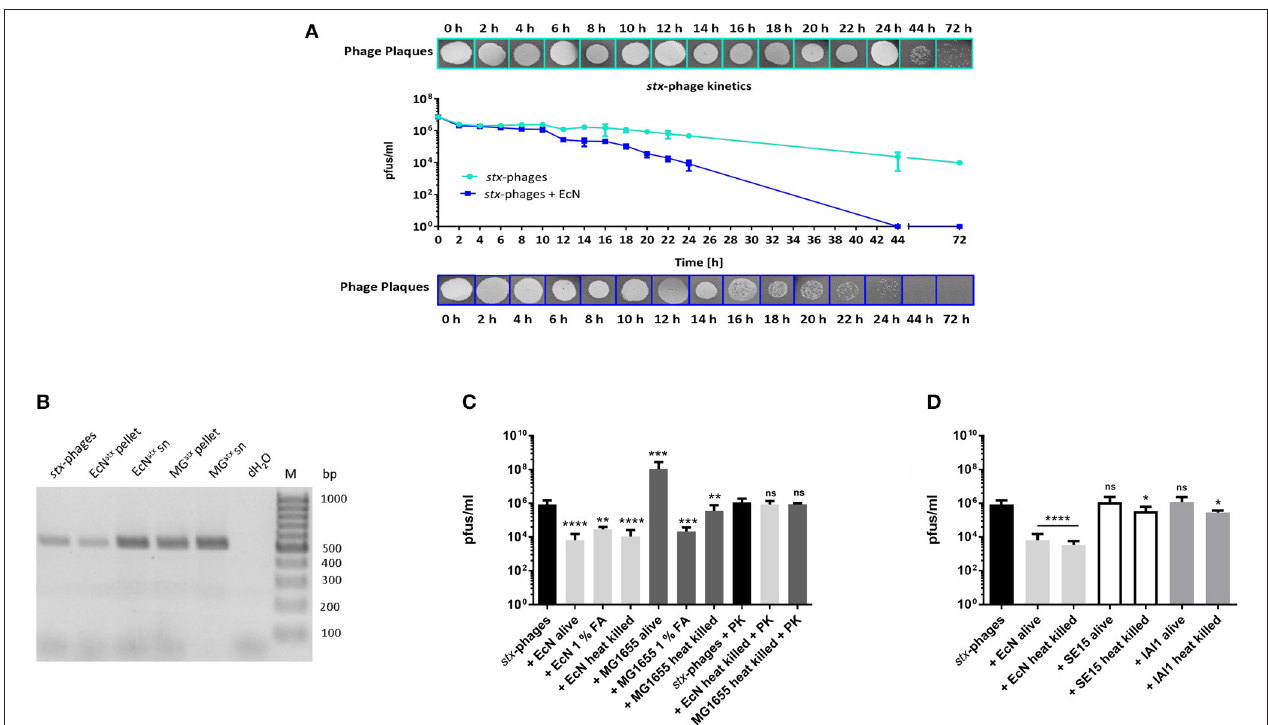
FIGURE 5 | Phage inactivation studies of EcN and stx -phages. (A) The stx -phage pfus/ml kinetics were analyzed in the presence and absence of EcN in a period of 72h. Phage titers were determined with the Phage Plaque Assays (PPA) (B) The phage localization PCR with the stx2 primers was performed on the washed bacterial pellet or the sterile filtered supernatant (sn) of EcN or MG1655 after being incubated with stx -phages (EcN stx , MG stx )for 24h. (C) Heat killed, heat killed and proteinase K (PK) treated or 1% formaldehyde (1% FA) fixed EcN or MG1655 were prepared as described in section Killing of E. coli and their phage inactivation capabilities were compared to the corresponding living E. coli . Bacteria were incubated for 24 h, static before being killed. The heat killed bacteria or the heat killed plus proteinase K treated bacteria were incubated for 24 h with the stx -phages and subsequently the phage titer was determined with the PPA. (D) Heat killed or living SK22D or the commensal control strains SE15 or IAI1 were incubated with the isolated stx -phages for 24 h before the pfus/ml were determined with a PPA. ns, not significant, * p < 0.05, ** p < 0.01, *** p < 0.001, and **** p <